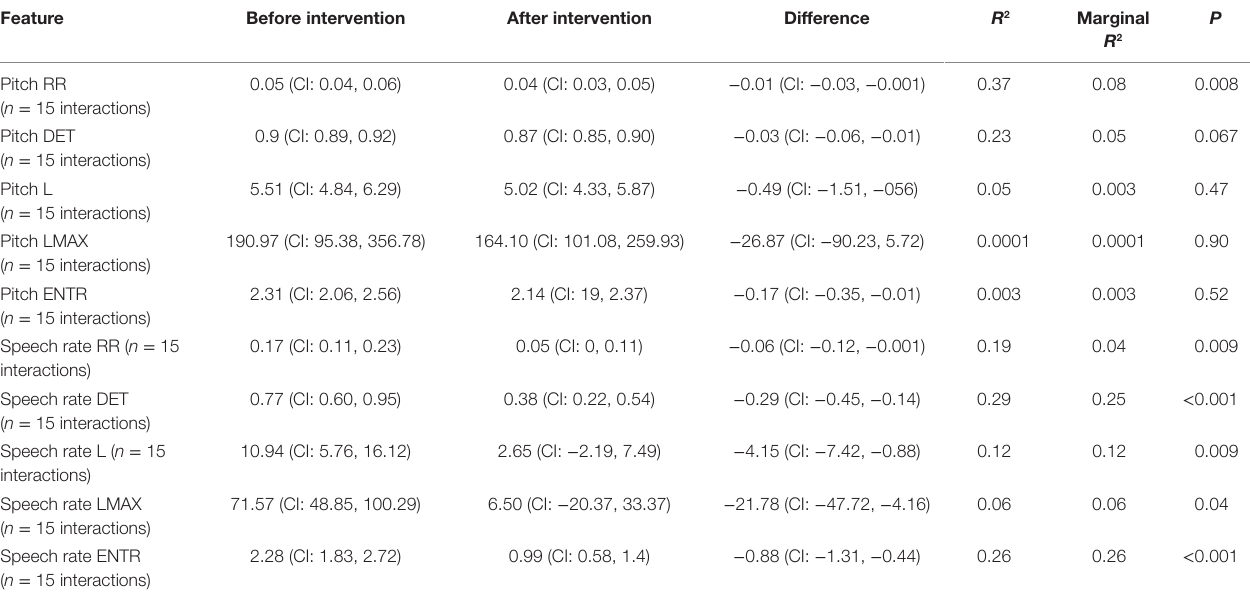
TaBle 6 | impact of intervention on linguistic